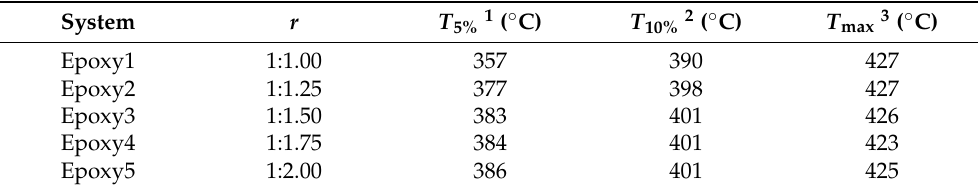
Figure 6. ( a ) Thermogravimetric Analysis (TGA) and ( b ) derivative thermogravimetric (DTG) curves of epoxy resins from room temperature to 800 ◦ C under a nitrogen atmosphere with a heating rate of 10 ◦ C/min. Table 3. Effect of the stoichiometric ratio of epoxy group and acyl group on the thermal stability of epoxy